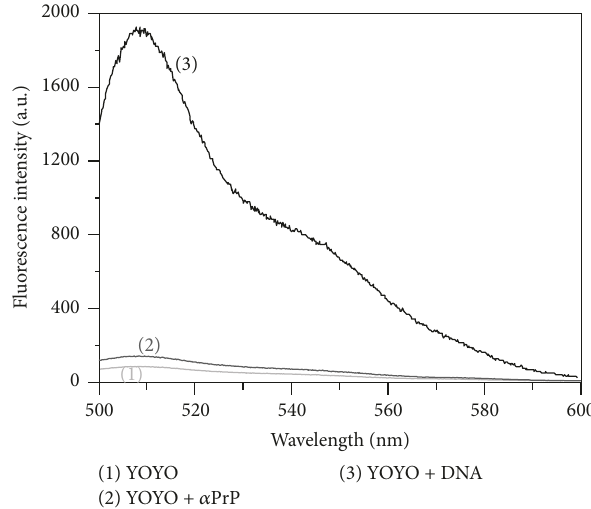
Figure 1: The specificity of oxazole yellow dye YOYO-1 towards DNA. The dye YOYO-1 (at concentration of 10nM) very specifically binds to or interchelated DNA molecules (mDNA, 1 𝜇 M DNA-ph concentration) and increases fluorescence by many folds. YOYO does not bind or increase its fluorescence intensity in the presence of prion protein ( 𝛼 -PrP, 2 𝜇 M).